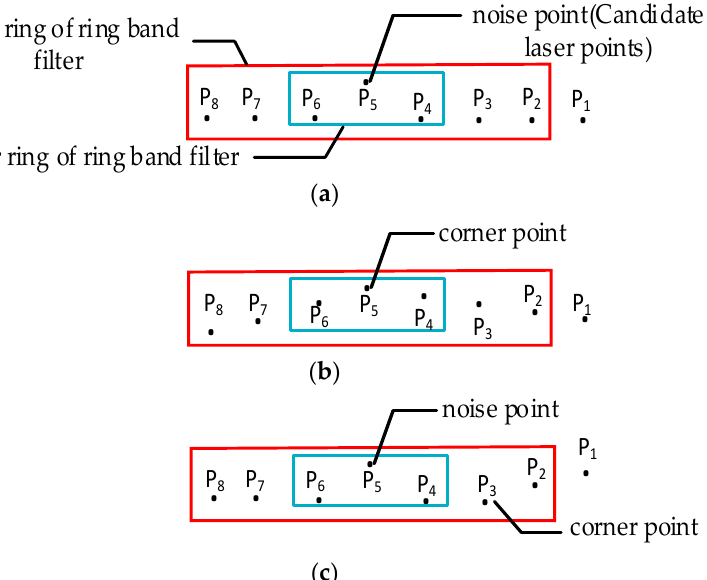
Figure 1. Ring band filter: ( a ) the candidate laser points are noise points; ( b ) the candidate laser points are corner points; ( c ) the candidate laser points are noise points, and there are corners in the ring.